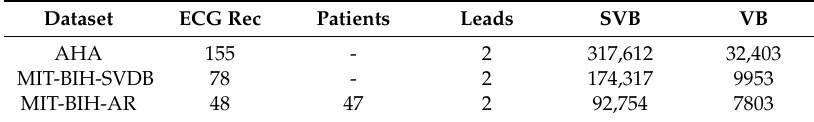
Table 2. The Description of Data sets used in this